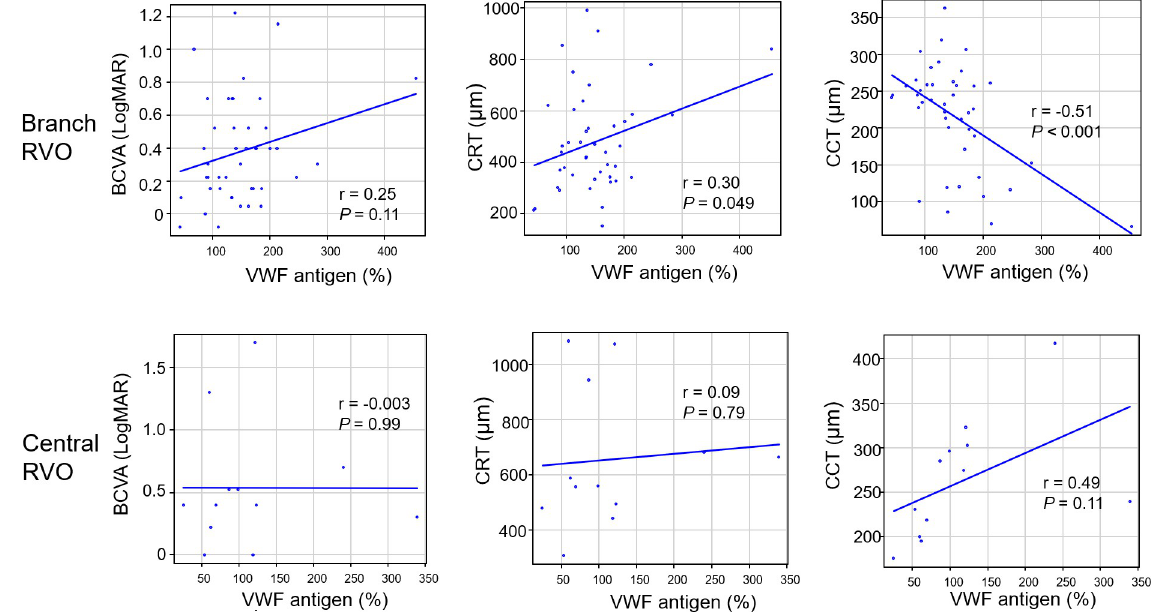
Fig 1. The correlation between VWF antigen and parameters (BCVA, CRT, and CCT) at baseline. In each graph, the horizontal axis presents the VWF antigen (%). BCVA, best-corrected visual acuity (LogMAR unit); CRT, central retinal thickness; CCT, central choroidal thickness; RVO, retinal vein occlusion.